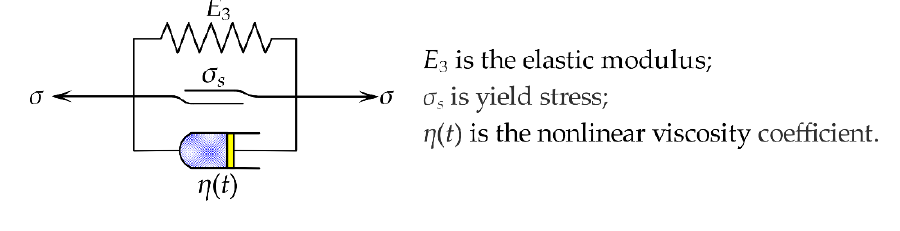
Figure 10. Nonlinear viscoelastic – plastic body.